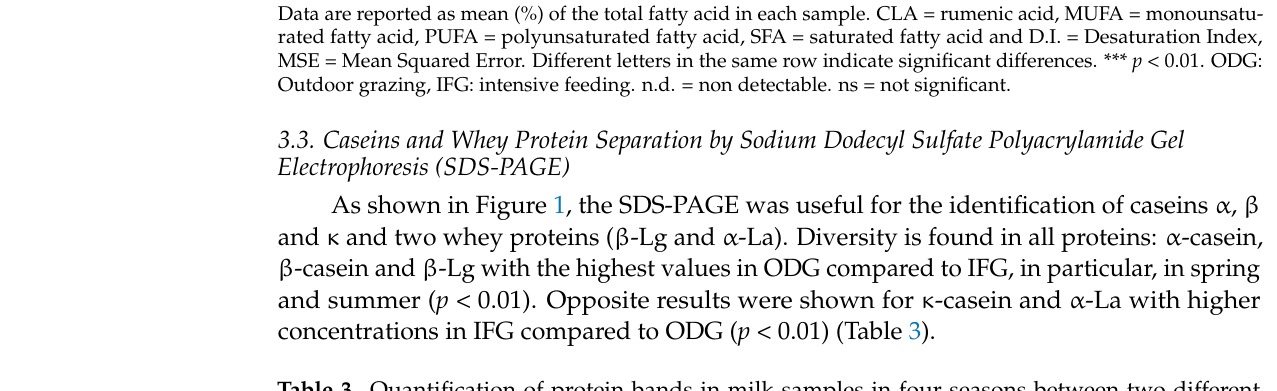
Table 3. Quantification of protein bands in milk samples in four seasons between two different farming